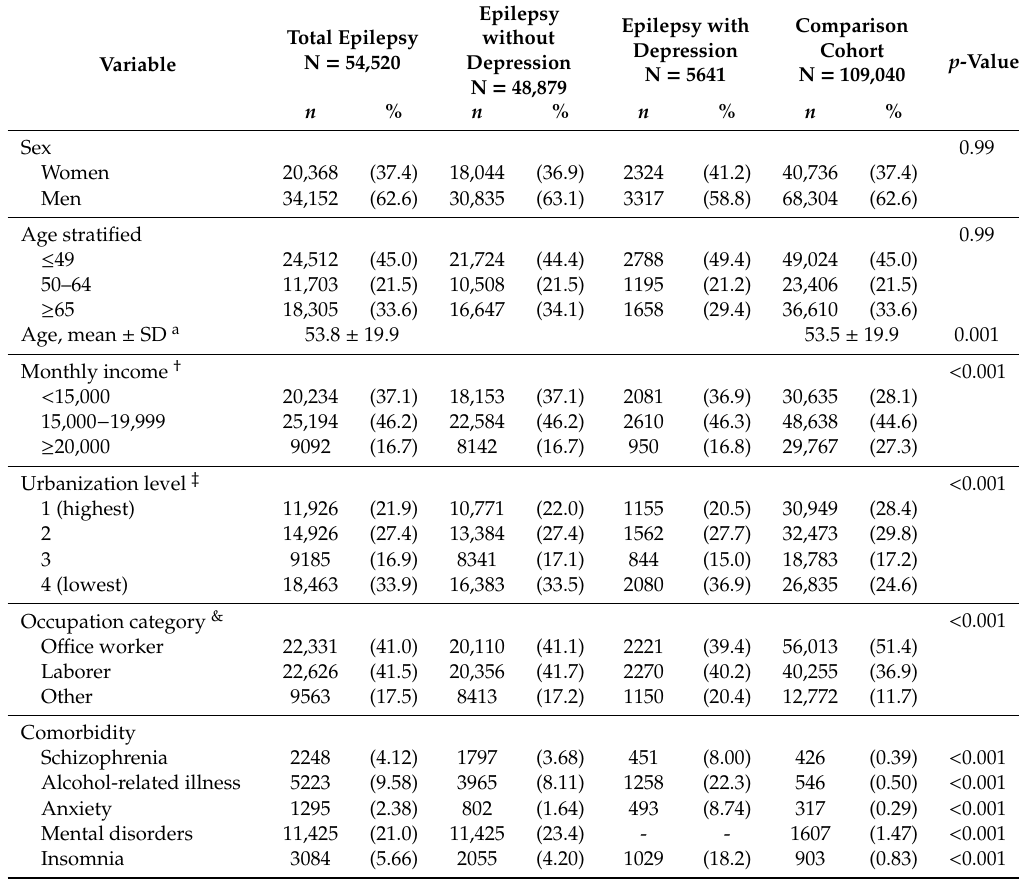
Table 1. Distributions of age, sex, and comorbidities between epilepsy and comparison cohorts.